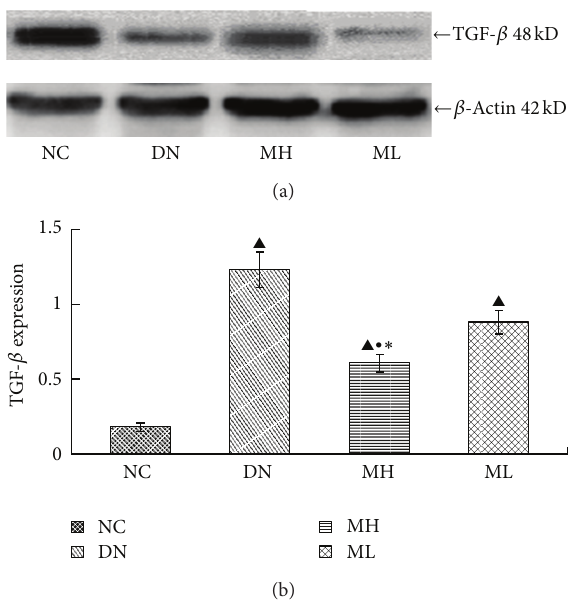
Figure 4: Expression of TGF- 𝛽 protein in each group by Western blot. (a) Western blot strip chart. (b) The gray graph shows the relative statistical values of TGF- 𝛽 for each group. Compared with the NC group, TGF- 𝛽 expression increased in the experimental groups, especially in the diabetic nephropathy group, with a sub- sequent decrease upon MG132 treatment, and a more pronounced, significant decrease in the MH group.